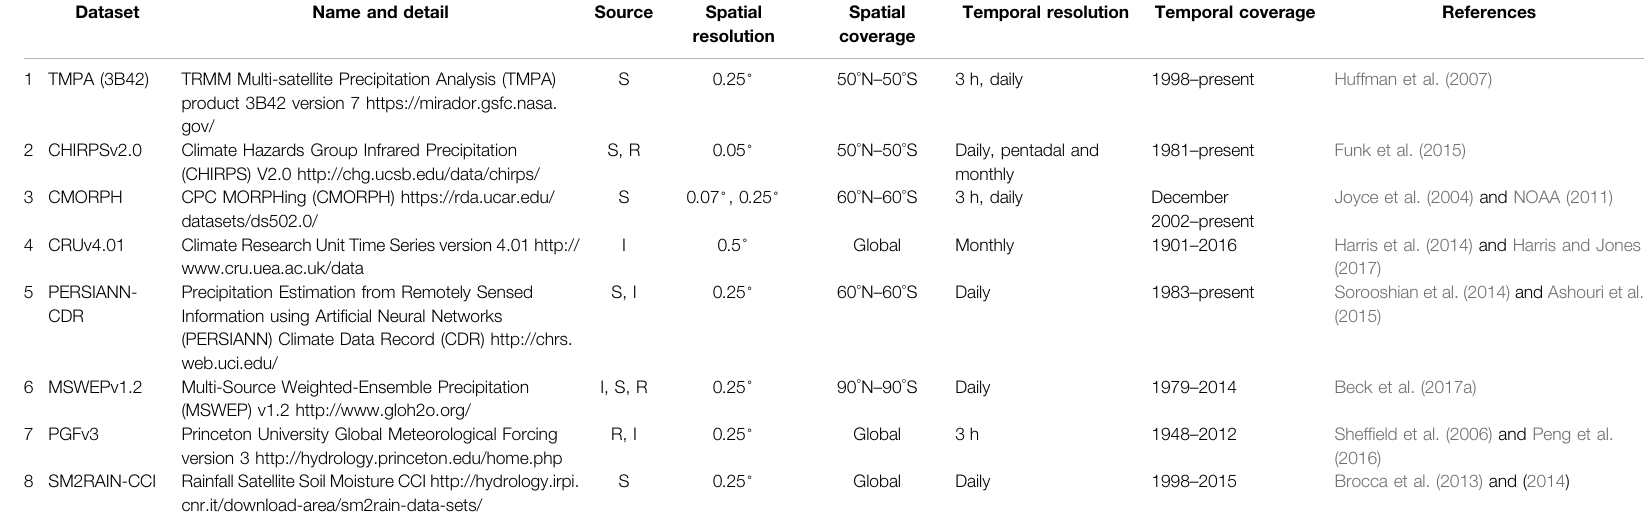
The abbreviations in the Source column, de fi ned as I, S, R are the abbreviations of the derived products: in situ , satellite, and reanalysis,